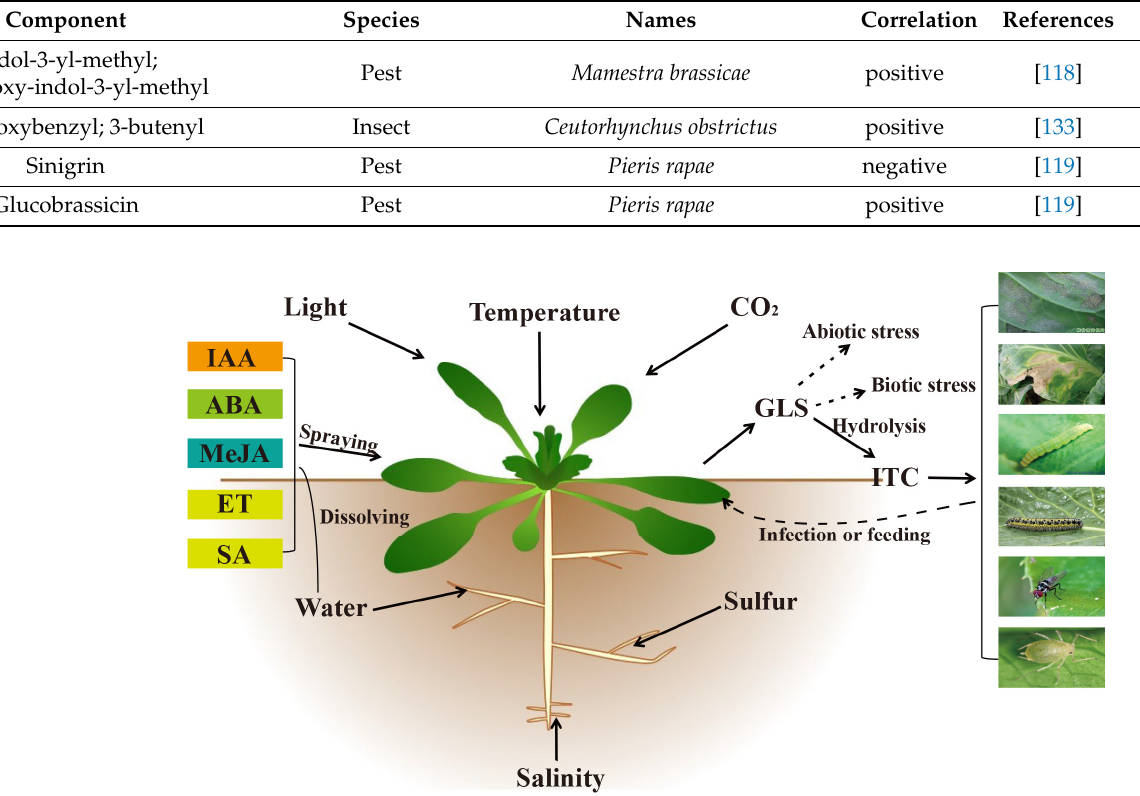
Figure 3. Factors affecting the synthesis of glucosinolate in cruciferous plants.